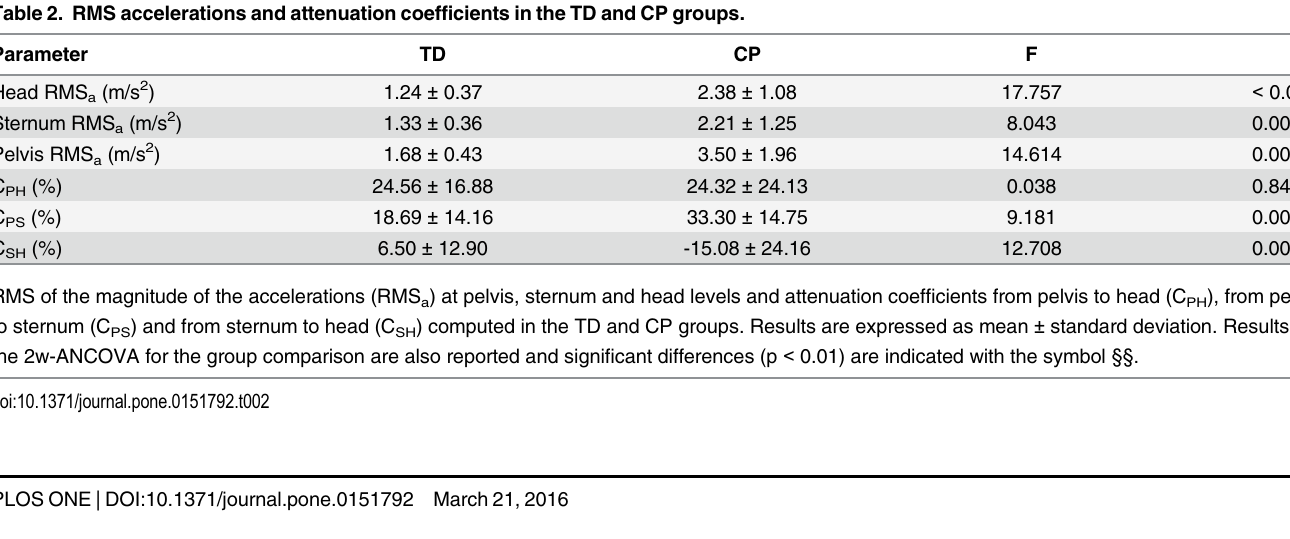
Table 2. RMS accelerations and attenuation coefficients in the TD and CP groups.